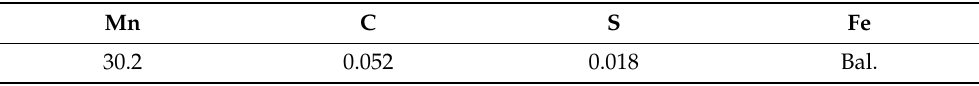
Table 1. Chemical composition of Fe-30Mn-0.05C (wt.%)